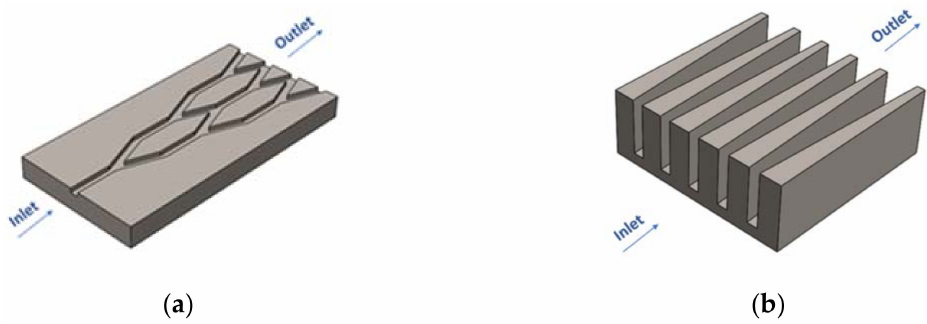
Figure 8. ( a ) Concept model of an enhanced surface with increasing cross-sectional area for a plane plate ( b ) and for a heat sink.